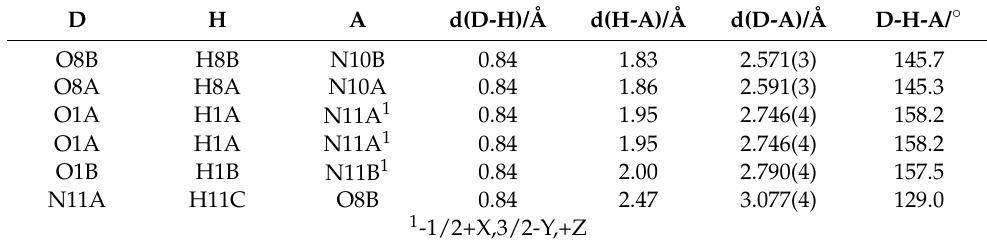
Table 2. Hydrogen bond geometry of compound 1 .